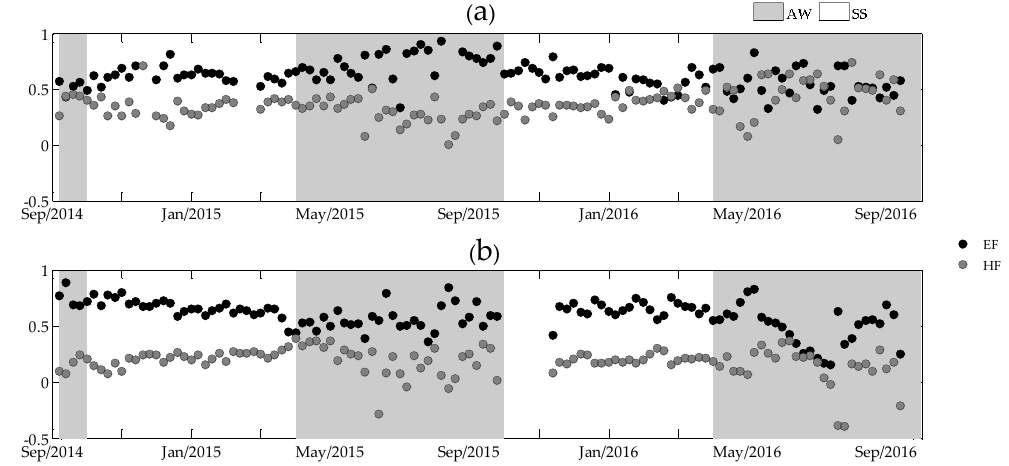
Figure 5. Six-day average of the evaporative fraction (EF = LE/R n ) and heat fraction (HF = H/R n ) for ( a ) SMA and ( b ) PAS from September 2014 to September 2016. The hatched areas refer to the AW periods.